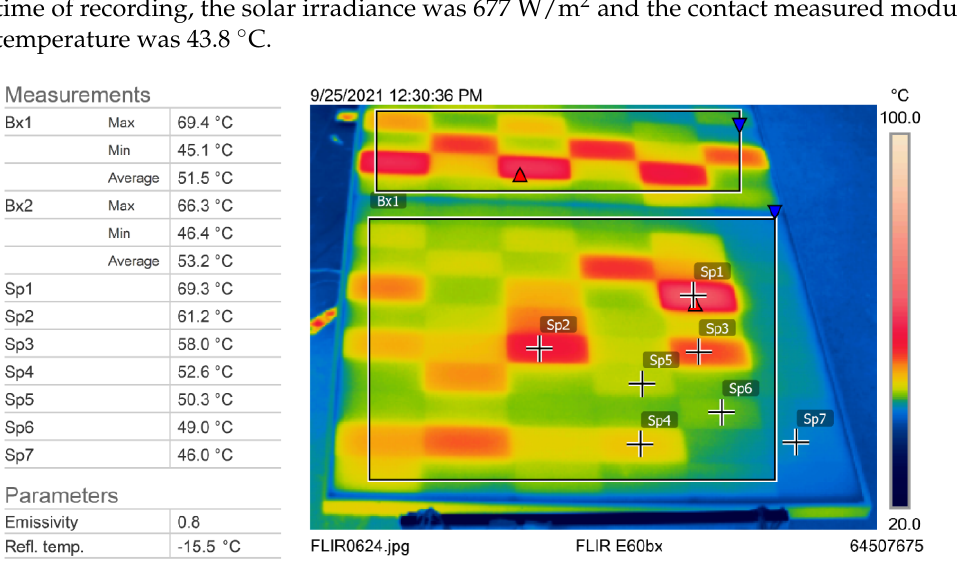
Figure 10. Thermography analysis of the new module.